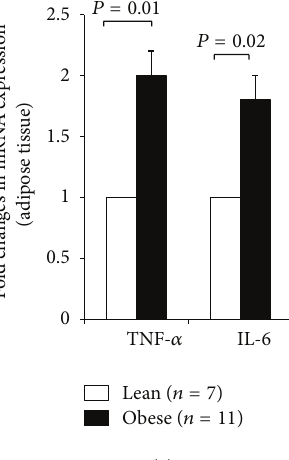
Figure 2: Expression of RANTES in obese subjects. (a) Western blot analysis of RANTES expression in PBMCs from lean and obese subjects. The bands reacting with anti-RANTES antibody were quantified as described in Section 2 and the relative intensity was determined after correction with Actin that was used as internal control to monitor loading efficiency. The blots shown are representative of three independent experiments with consistent results. The data are presented in the form of a bar graph on the right of the figure as fold changes of RANTES protein expression in obese compared to lean subjects. (b) Characterization of the monocyte subpopulations and T cells in peripheral blood from lean and obese participants. Monocytes subsets were defined by staining for CD14 (PE), T cells by CD3 (FITC), and expression of intracellular RANTES (APC) was analyzed. Left and right upper panels are representative dot plots of CD3 and RANTES expression on/in T cells from lean and obese participants, respectively. Left and right lowest panels are representative dot plots of CD14 and RANTES expression on/in monocyte subsets from lean and obese participants, respectively. The double-positive populations (i.e., CD3+RANTES+, CD14+RANTES+, and CD14++RANTES+) were analyzed for mean RANTES fluorescence intensity. (c) Analysis of RANTES expression by immunohistochemistry (IHC) in the subcutaneous adipose tissues from lean and obese nondiabetic participants. Aperio software was used to quantify positive staining (indicated by arrows) and quantified values relative to lean controls are plotted in a bar graph at the bottom. (d and e) Analysis of RANTES mRNA expression by quantitative real-time PCR (qRT-PCR) between lean and obese subjects. Total RNA was isolated from PBMCs (d) and adipose tissue biopsies (e). The data are presented as fold changes in obese compared to lean subjects after normalization with the GAPDH reference gene. (f and g) Analysis of TNF- 𝛼 and IL-6 expression at the protein level by IHC (f) and at the mRNA level by qRT-PCR (g) in the adipose tissue from lean and obese subjects. In IHC experiments, Aperio software was used to quantify positive staining as indicated above and the values are illustrated at the bottom as fold changes compared to lean. Mann-Whitney test was used to determine significance of difference between the lean and obese subjects. For each experiment, the sample size from each group is indicated by 𝑛